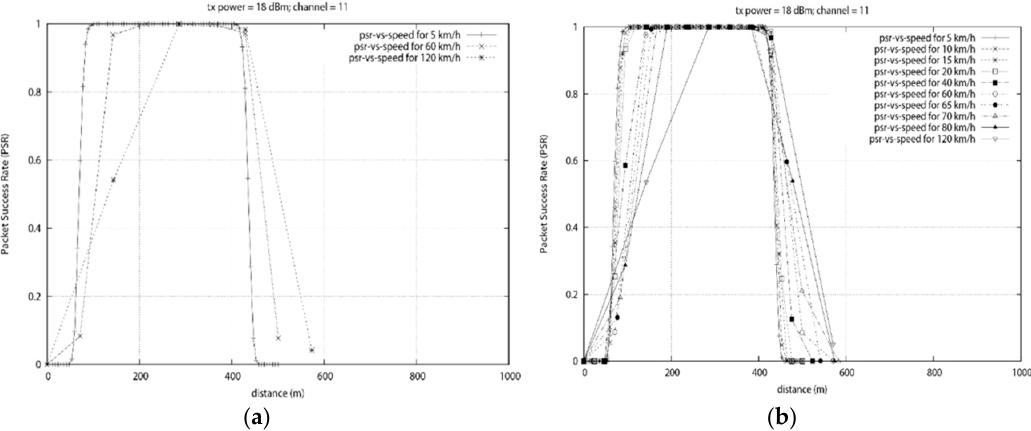
Figure 22. This figure depicts the Speed vs. Reliability in Residential Road. ( a ) Speed vs. reliability with concentrator at x = 250 m ( b ) Speed vs. reliability with multiple speeds.